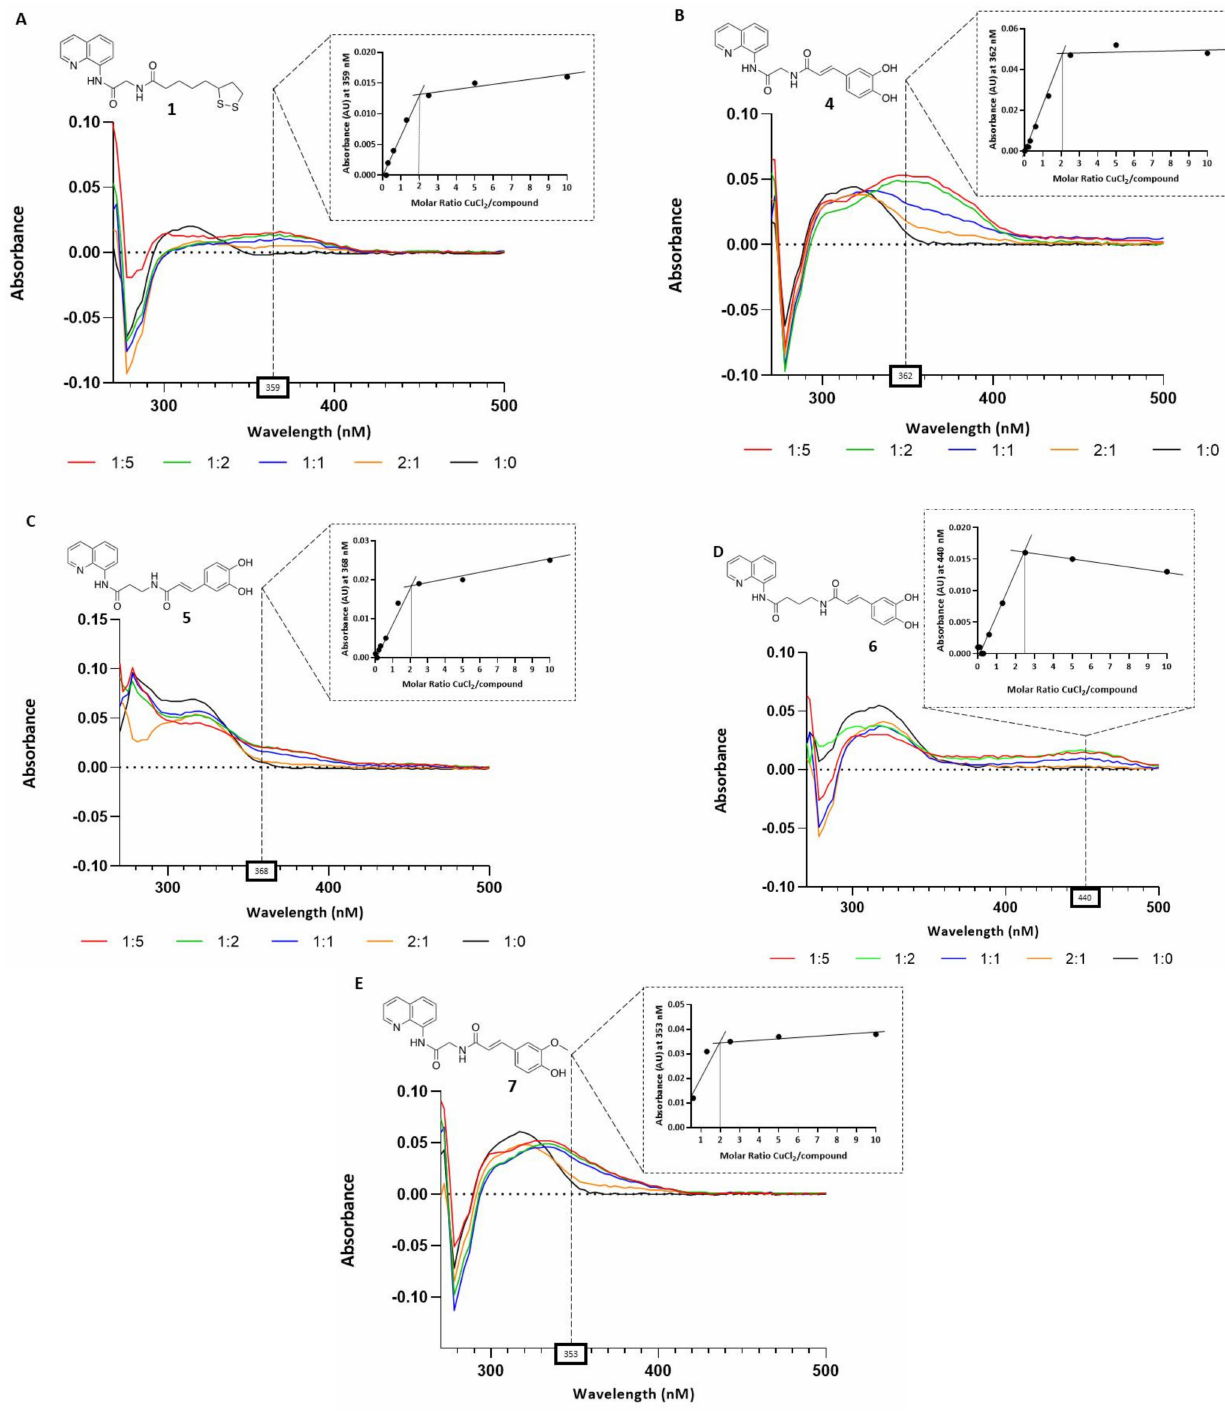
Figure 2. Copper-chelating activity of compounds 1 , 4 , 5 , 6 , and 7 . Graphs ( A – E ): UV spectra of the compounds alone (10 µ M, in black line) and treated with increasing concentrations of CuCl 2 (5, 10, 20, and 50 µ M). The box on the top of each graph shows the Cu 2+ -ligand complex molar ratio at the maximum variation of absorbances for the tested compounds (359 nm for 1 , 362 nm for 4 , 368 nm for 5 , 440 nm for 6 , 353 nm for 7